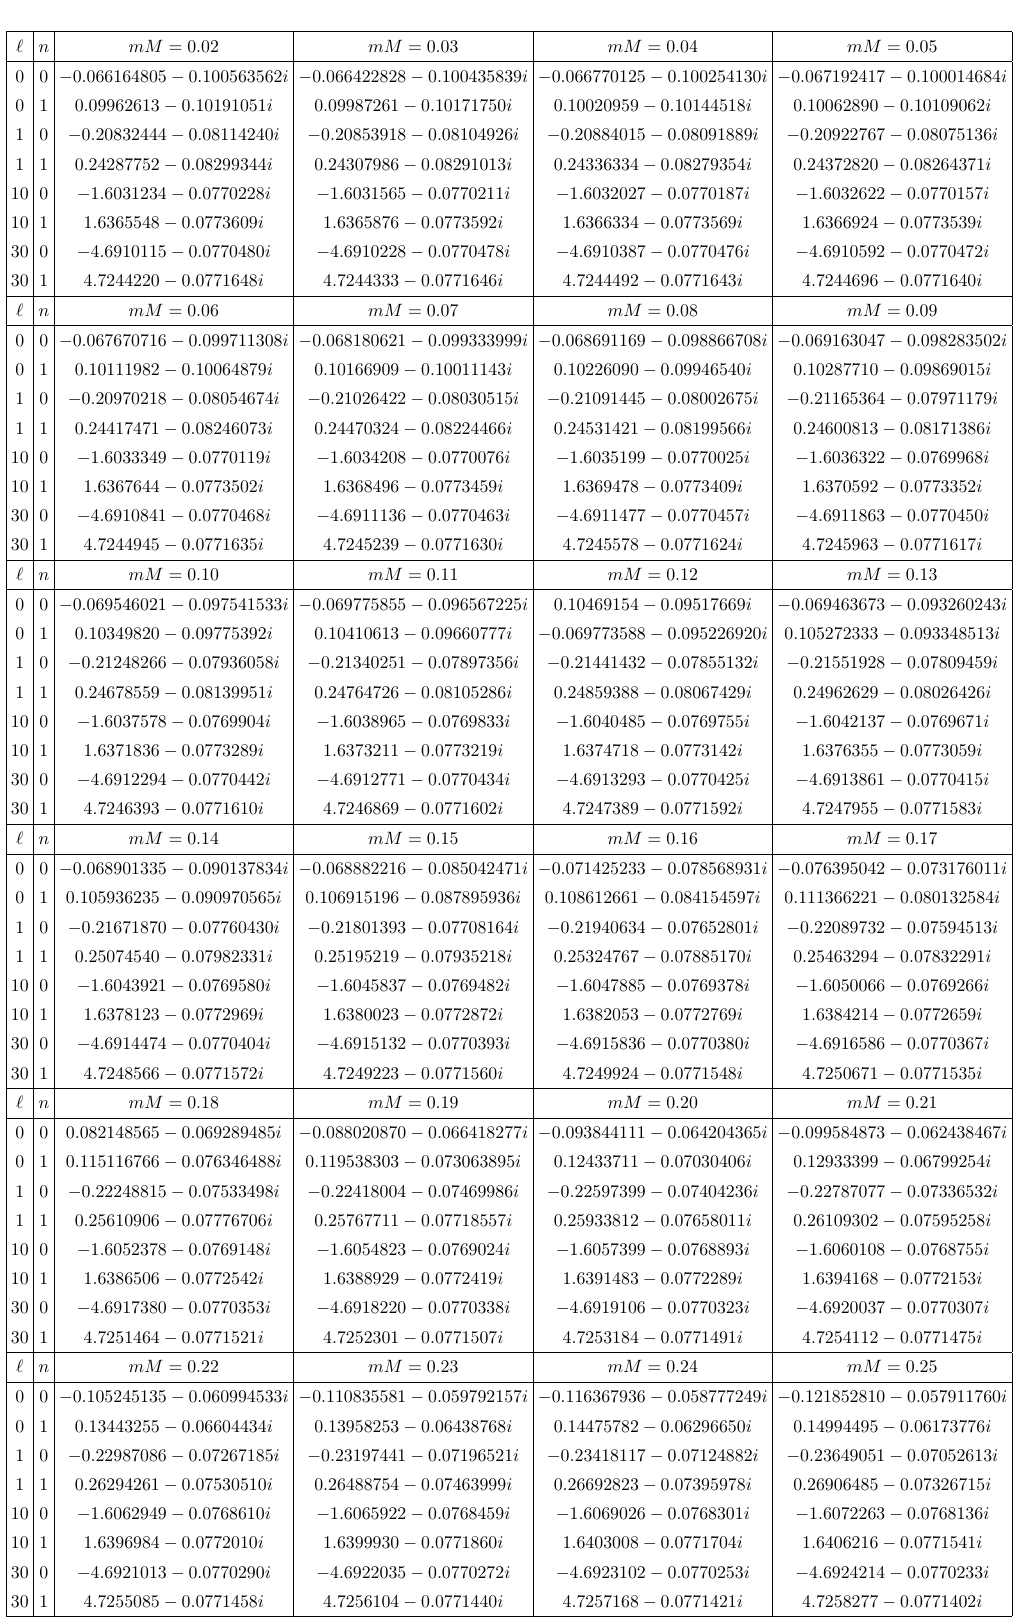
Table 10 . Dominant photon sphere QNFs ( ωM ) for massive scalar fields with qM = 0 . 5 , ‘ = 0 , 1 , 10 , and 30 in the background of a RNdS black hole with Λ M 2 = 0 . 04 , and Q/M = 0 . 1